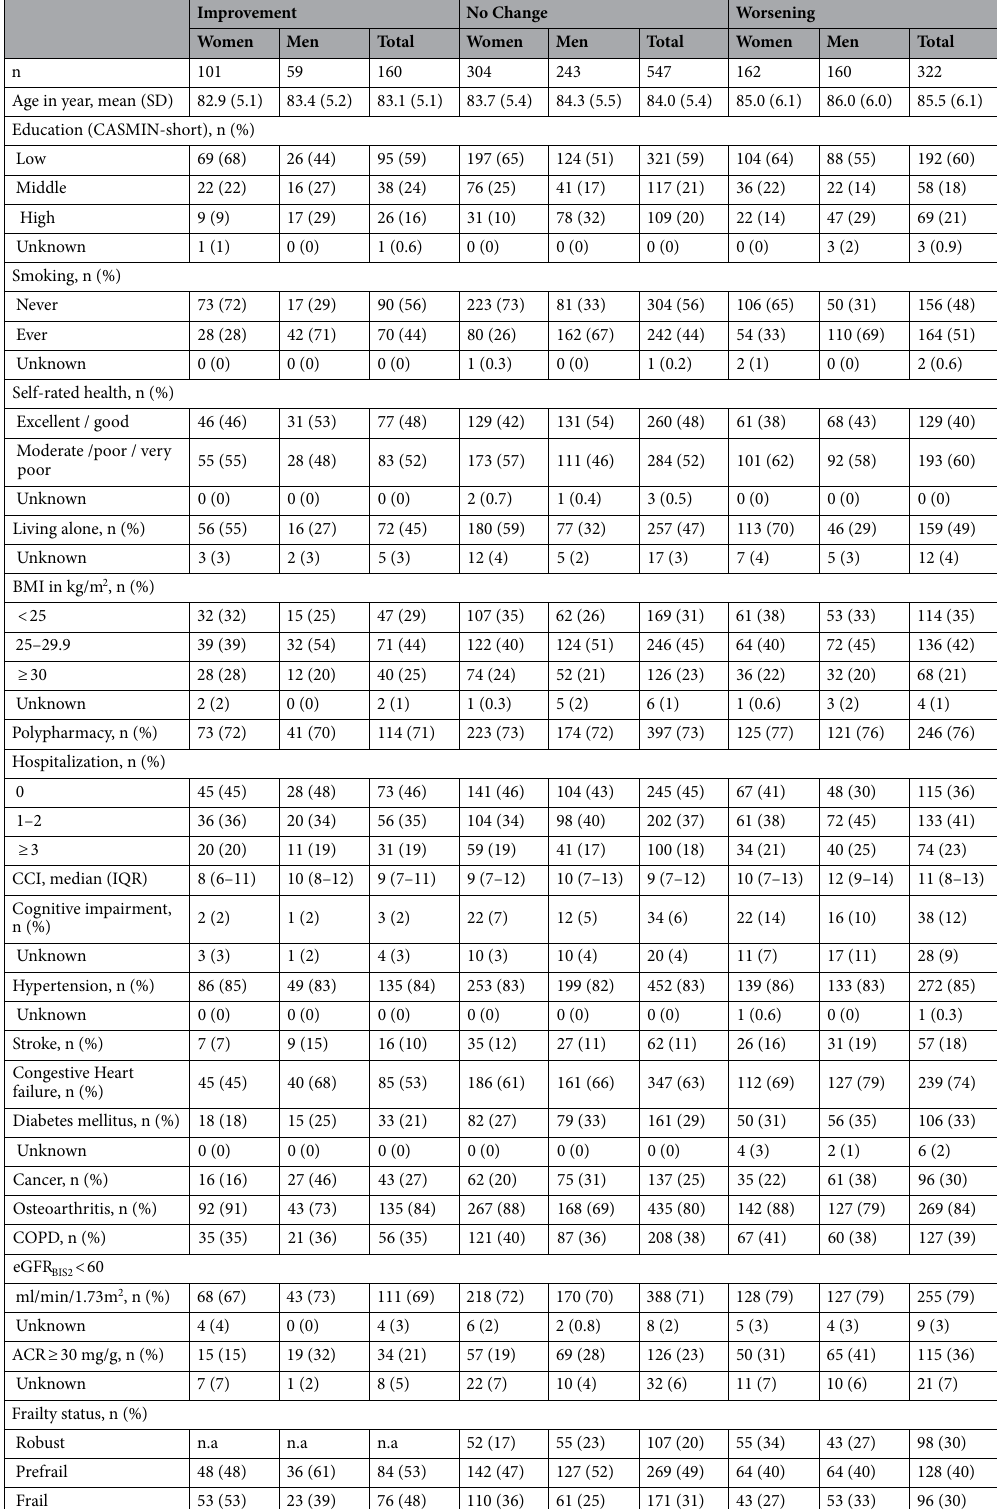
Table 2. Main baseline characteristics by frailty transition status after 2.1 years and stratified by gender. SD standard deviation, n.a. not applicable, BMI body mass index, CCI Charlson Comorbidity Index,